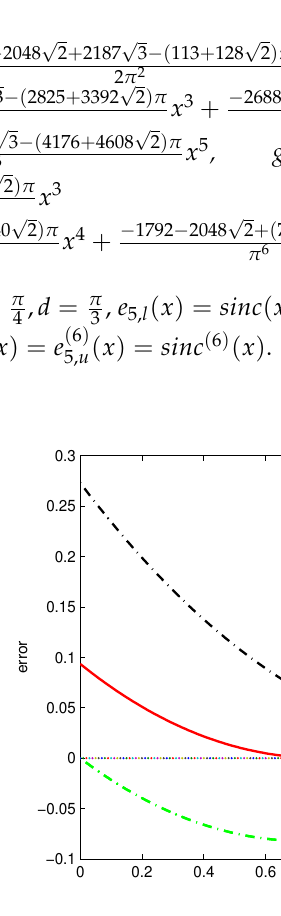
Figure 1. Error plots between sinc(x) and the bounds of Equations (2) and (12).